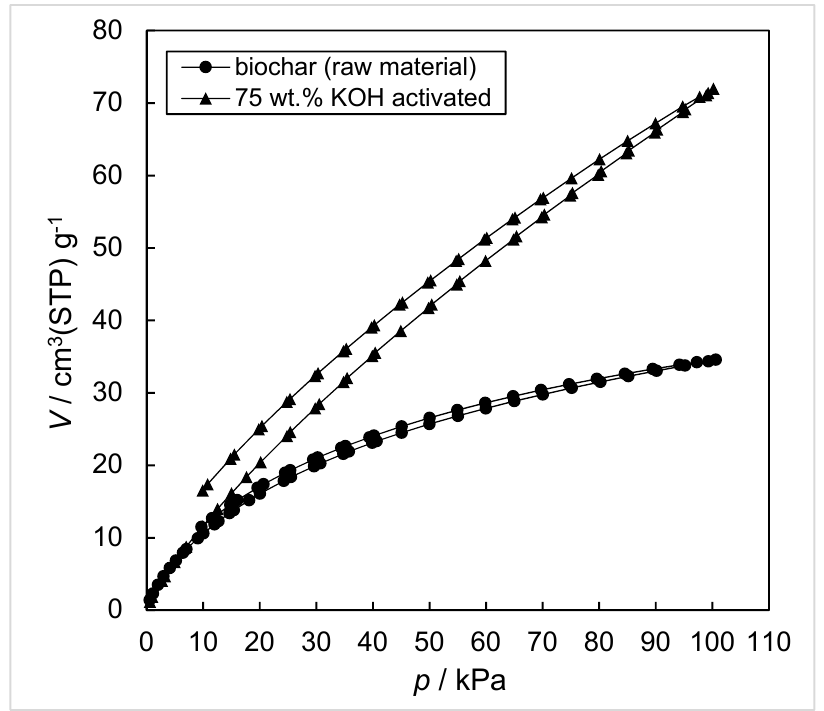
Figure 4. The CO 2 adsorption isotherms at 298 K of the biochar as raw material and the 75 wt.% KOH-activated biochar.